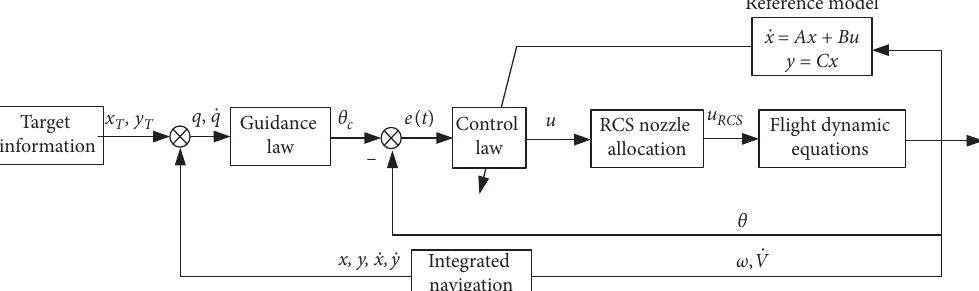
Figure 4: Guidance and control structure of maneuverable reentry vehicle. A guidance command is generated according to the guidance law by the current location information and the location information of the target. The control system controls the nozzle according to the guidance command.